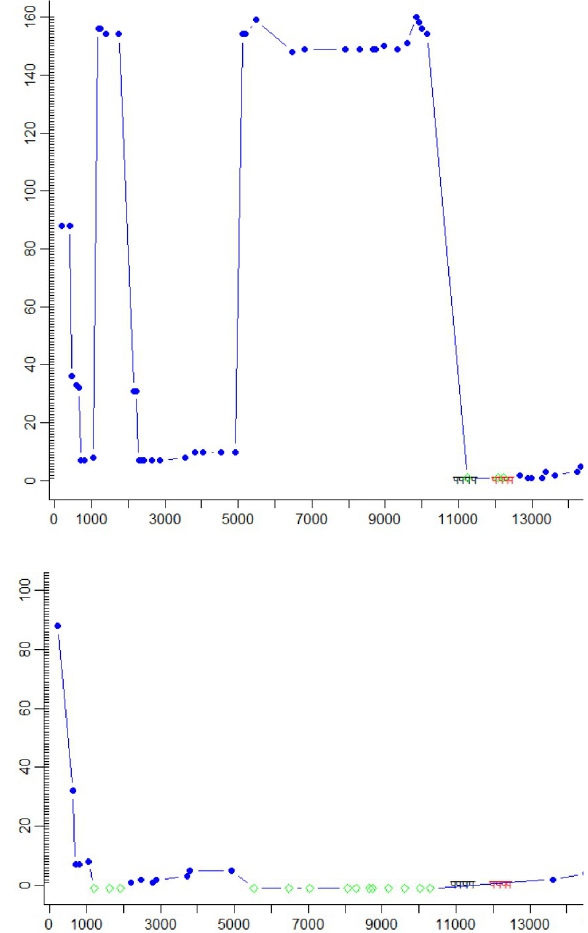
Figure 4: different fixation-to-symbol mappings of two mapping approaches between time stamps 5000 and 10000. Top:fixation- to-word mappings on the last words in the source text (blue dots); Bottom: mappings on the first word in the target text (green diamonds)